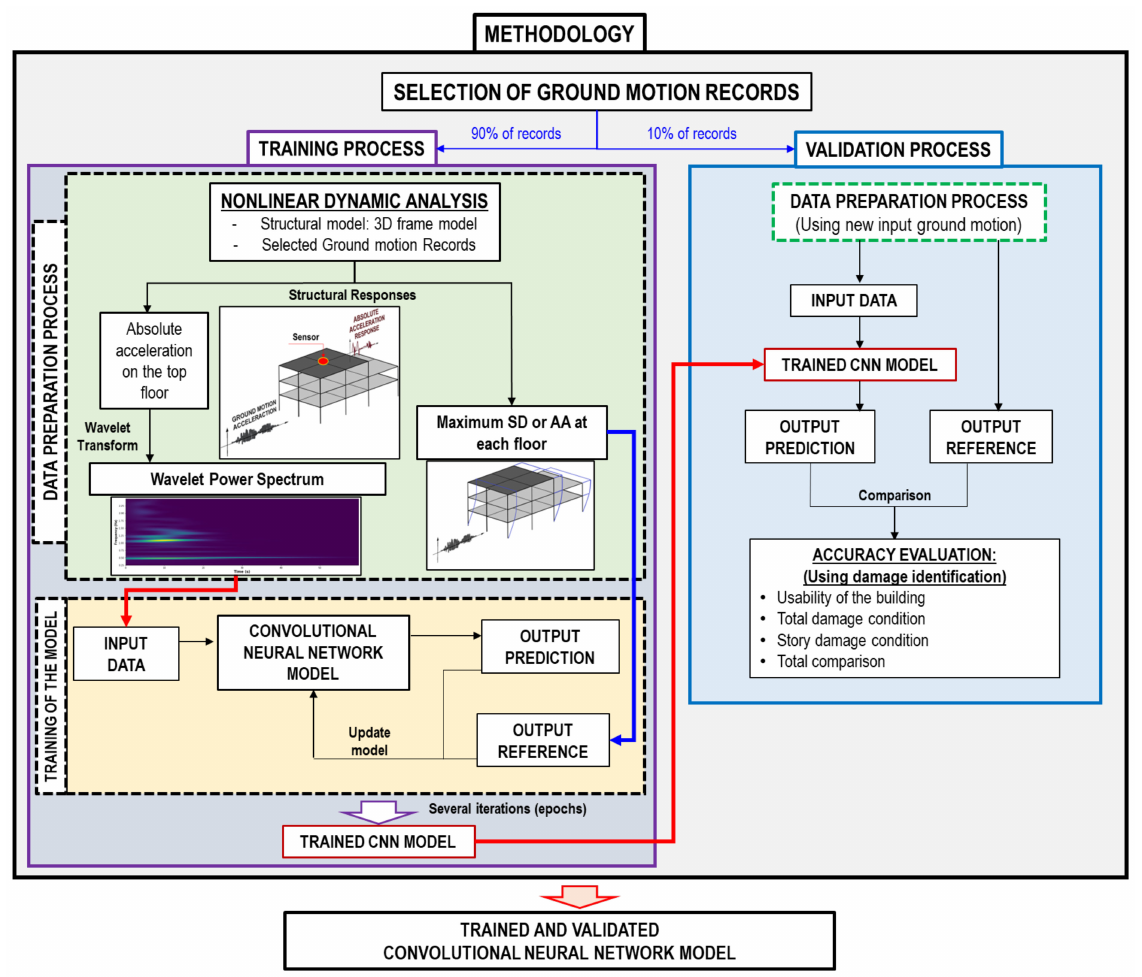
Figure 1. Methodology flowchart to obtain the Convolutional Neural Network